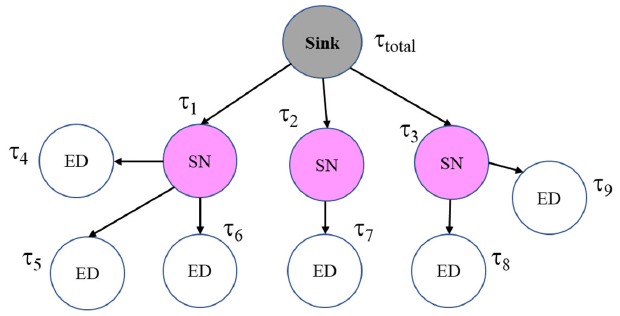
Figure 3. Proportionally divided BEA.